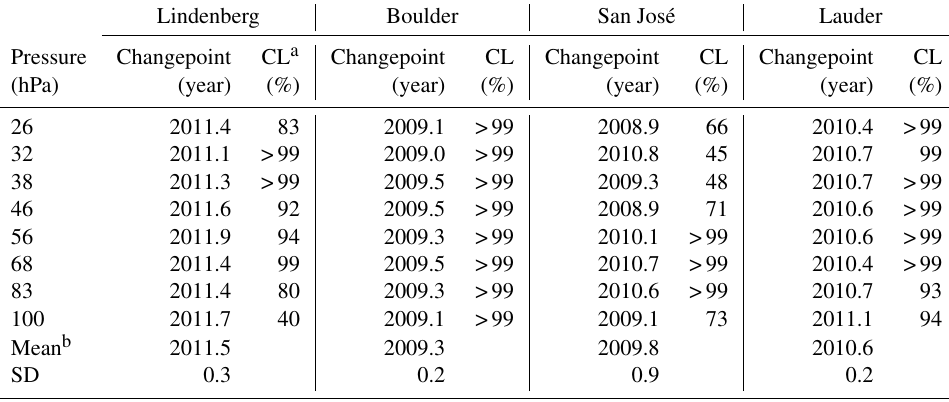
Table 2. Changepoint dates and their confidence levels, MLS version 3.3.